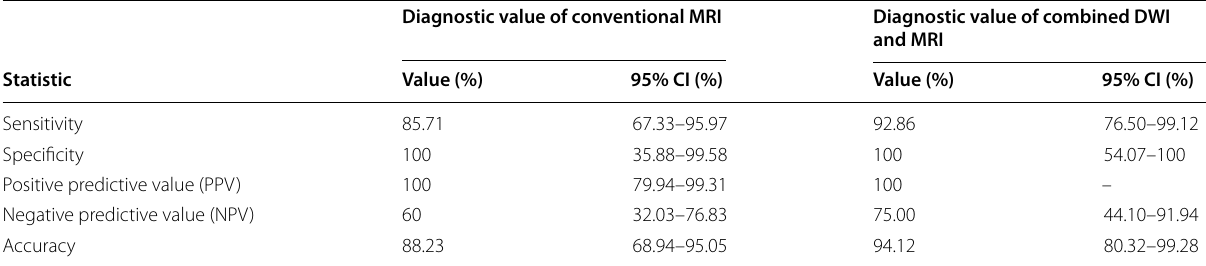
Table 5 Comparison of diagnostic value of conventional MRI and diagnostic value of combined DWI and MRI Diagnostic value of conventional MRI